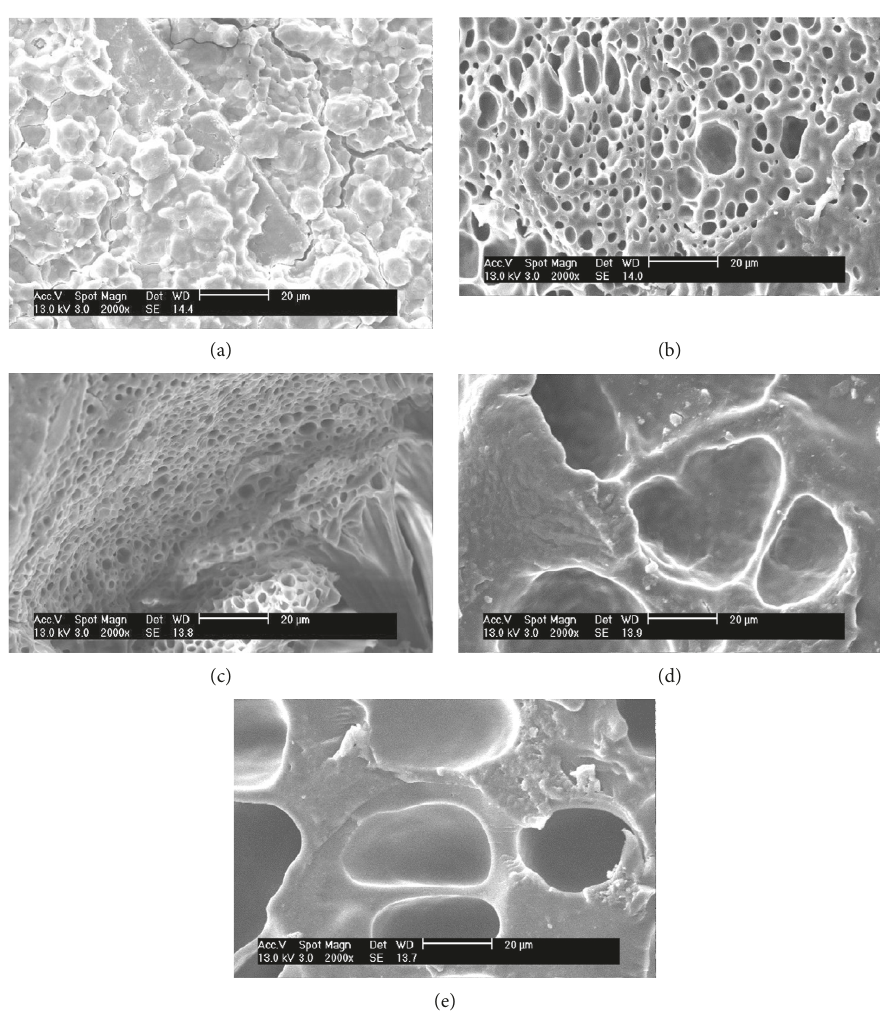
Figure 3: Scanning electron micrographs (2000x) of black glutinous rice with/without superheated steam treatment. (a) Uncooked rice without superheated steam treatment (control). (b) Uncooked rice with superheated steam at 250 ° C. (c) Uncooked rice with superheated steam at 300 ° C. (d) Precooked rice with superheated steam at 250 ° C. (e) Precooked rice with superheated steam at 300 °